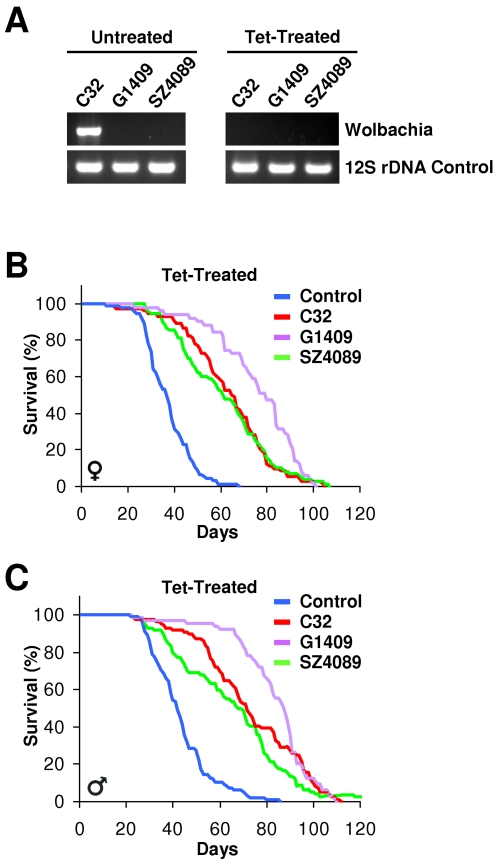

Snz Mutant Longevity Is independent of Endosymbiont Effects.(A) Detection of Wolbachia in PCR assay using Wolbachia-specific primers (upper panels) and universal bacterial 12S rDNA primers as a control (lower panels). Only the C32 line was infected with Wolbachia (upper left panel) and infection was eliminated after tetracycline treatment (upper right panel). (B, C) The lifespan of female (B) and male (C) control and tetracycline-treated C32, G1409, and SZ4089 flies are plotted. (n>80) p<0.0001 by log-rank test between control and all snz mutant alleles. Representative data from multiple experiments is shown.